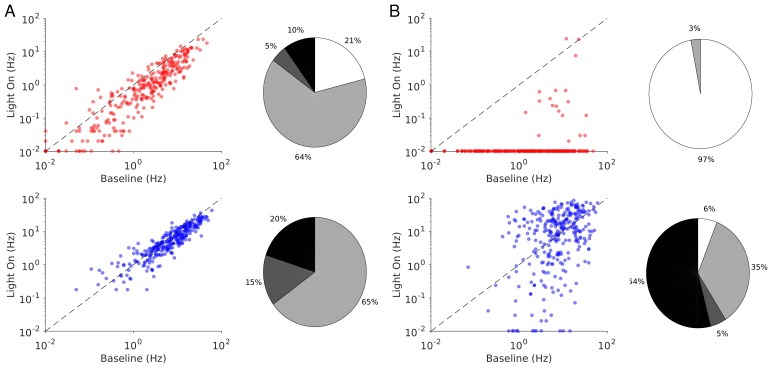
Single neuron firing rates in the PC and PV populations upon PV activation for two values of the light intensity (Model 1 with JEE<JEE∗).(A) Single neuron firing rates at baseline vs. at Γopto=0.5mW.mm-2. (B) Same for Γopto=1mW.mm-2. Top: PCs. Bottom: PV neurons. Scatter plots of 300 randomly chosen PC and PV neurons. Pie charts for the whole population. Firing rates were estimated over 100s simulation time. Neurons with rates smaller than 0.01Hz are plotted at 0.01Hz. Color code as in Figure 6. Parameters as in Figure 7.